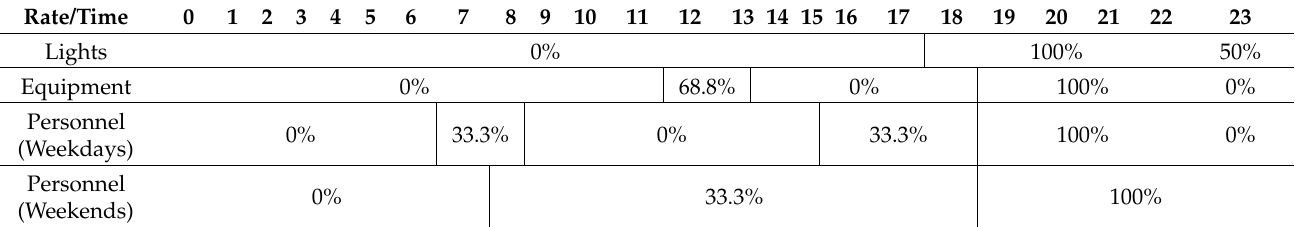
Table A4. The application rate of lights, equipment and personnel of living room at different times.